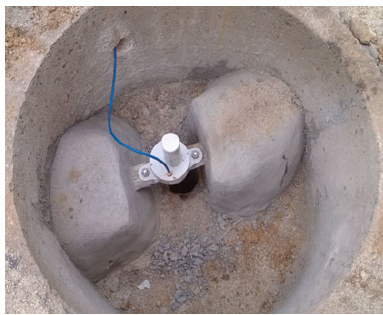
Fig. 7 Field installation of displacement